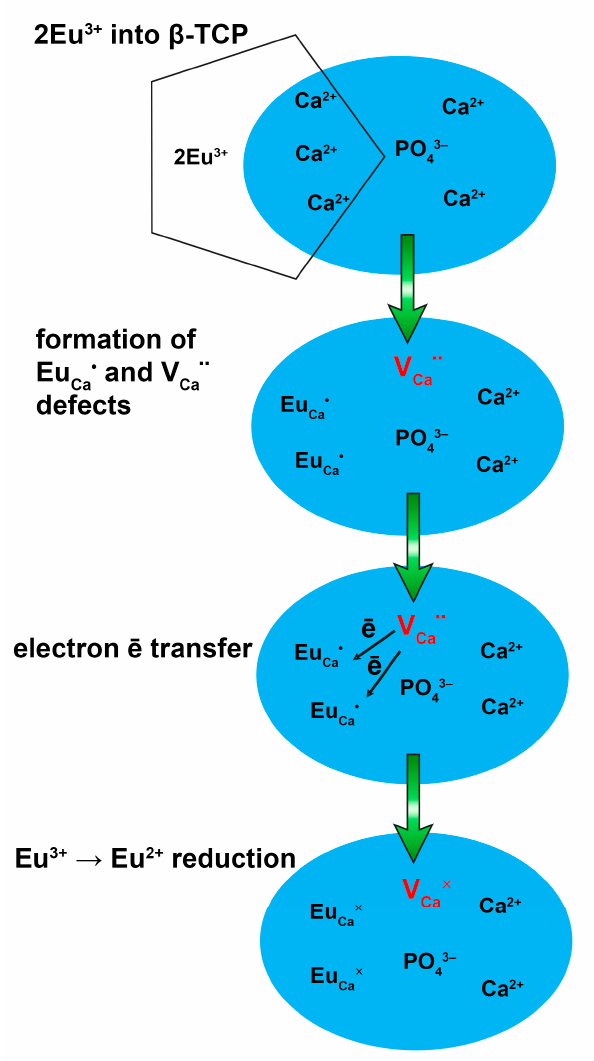
Figure 16. The scheme of abnormal reduction of Eu 3+ to Eu 2+ in the β -TCP-type host.